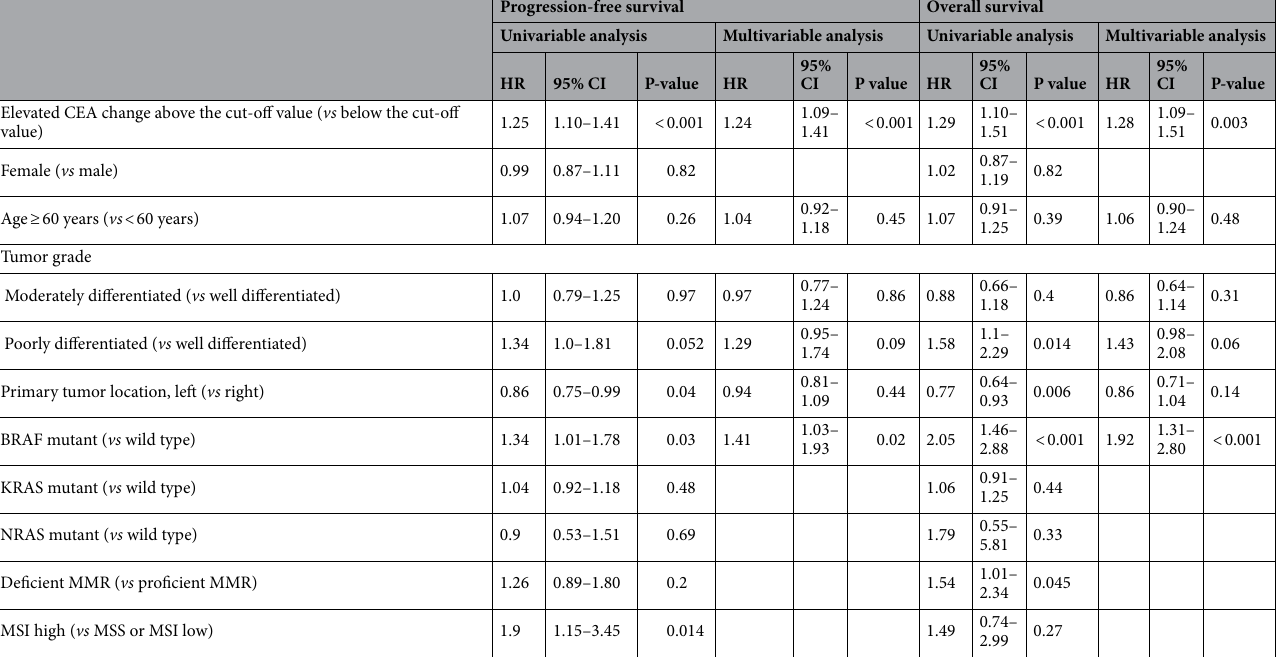
Table 4. Univariable and multivariable analyses of prognostic factors in terms of progression-free survival (PFS) and overall survival (OS). HR, hazard ratio; CI, confidence interval; MMR, mismatch repair; MSI, microsatellite